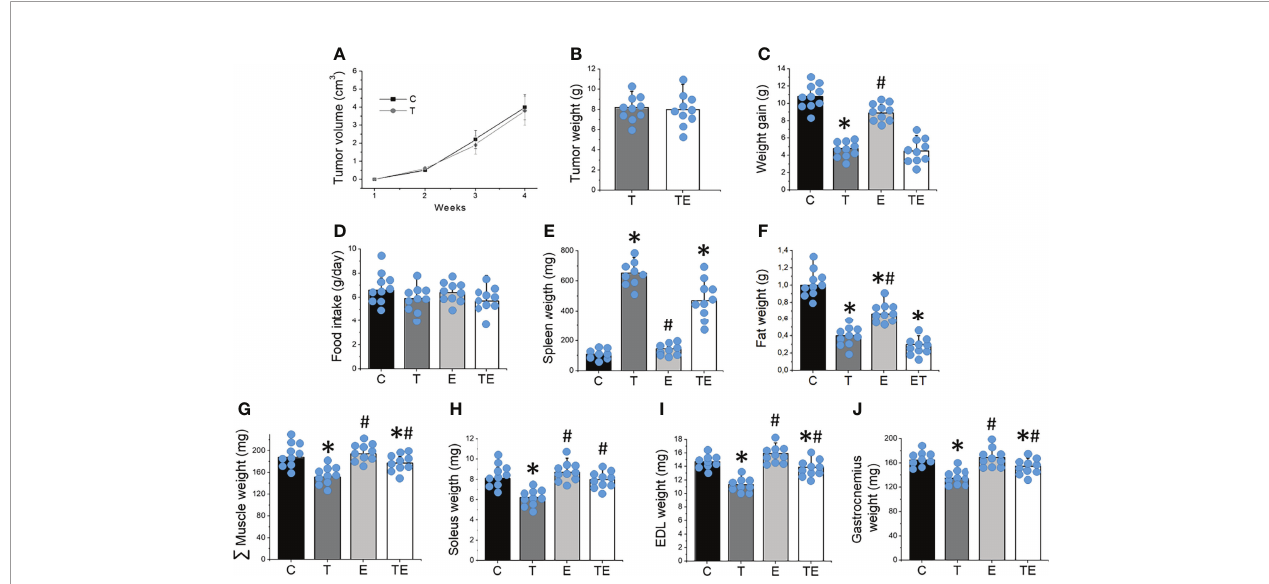
FIGURE 1 | Resistance training prevented tumor-induced muscle wasting. (A) tumor volume over the 4 weeks (n = 10) and (B) tumor mass (n = 10), (C) weight gain (n = 10), (D) food intake (n = 10), (E) spleen and (F) fat weight (n = 10), (G) sum of skeletal muscle mass (n = 10), (H) soleus (n = 10), (I) EDL (n = 10) and (J) gastrocnemius (n = 10) mass after 4 weeks of experiment for groups control, tumor-bearing, exercised and tumor-bearing exercised. Results are mean ± standard deviation. *p < .05, compared with control; # p < .05, compared with Tumor-bearing group (by ANOVA two-way followed by Tukey post-hoc test). C, control group; E, exercised; T, tumor-bearing; TE, tumor-bearing